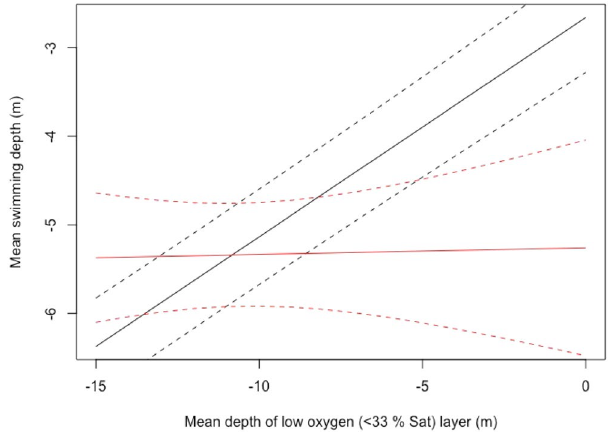
Figure 4. Model prediction of fish response to changes in the minimum depth of the low DO bottom layer mediated by the maximum depth of the high temperature surface layer. Black line indicates response to low DO layer depth when the high temperature surface layer was above 1 m depth, red line indicates response when the high temperature surface layer extended below 3 m. Dashed lines show 95% confidence